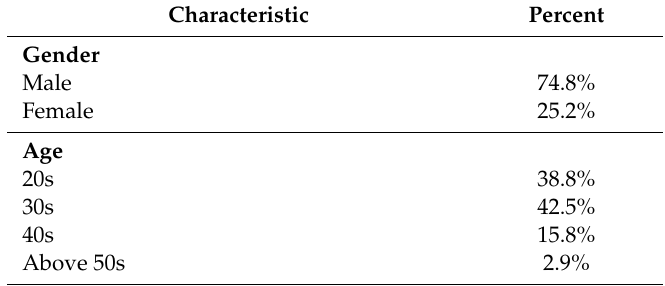
Table 1. Descriptive characteristics of our sample.